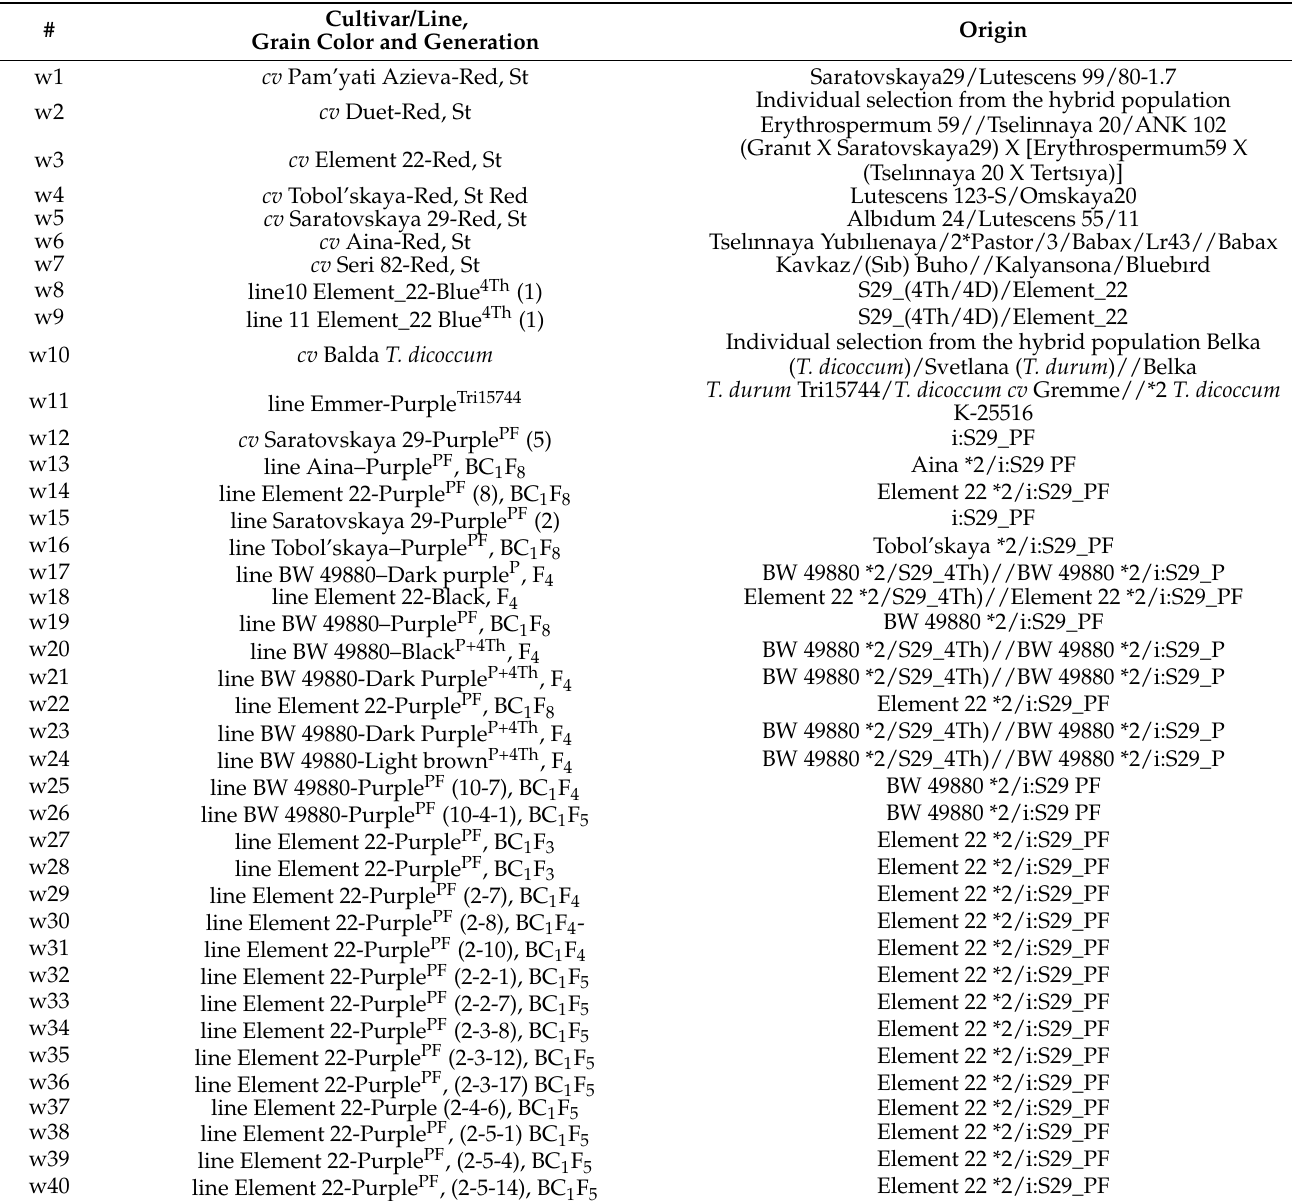
Table 1. Purple wheat sample types used in this